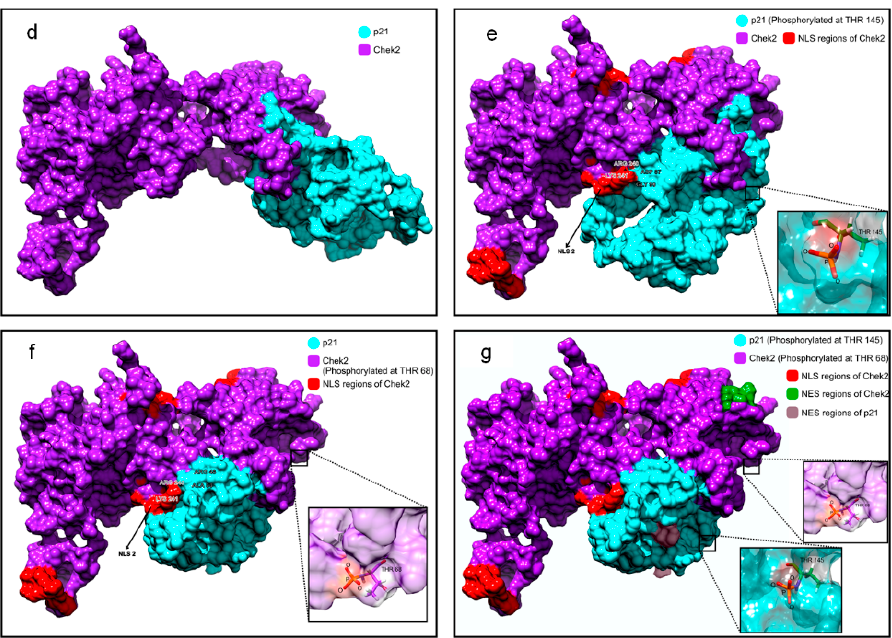
Figure 7. Interaction between p21 and Chk2 proteins. Cells were treated with 100 µ M 5FU for 48 h and the protein–protein interaction of p21-p-Chk2 T68 was analyzed by proximity ligation assay (HT29) (red signals indicate the protein–protein interaction between p21 and p-Chk2 T68 . ( a ) Fluorescence images of untreated control HT29 cells (40 × magnification) and 5FU-treated HT29 cells (40 × and 100 × magnification) (scale bar: 50 µ m); ( b ) confocal images. ( c ) 5FU-treated HCT116 cell lysates were